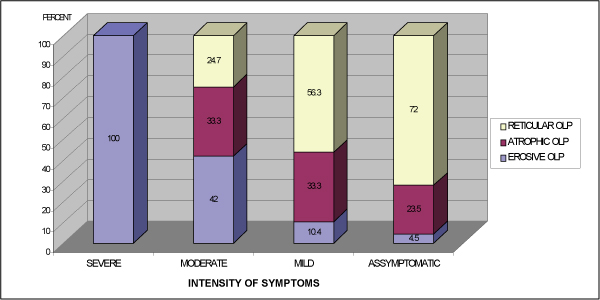
The intensity of symptoms in subtypes of oral lichen planus.